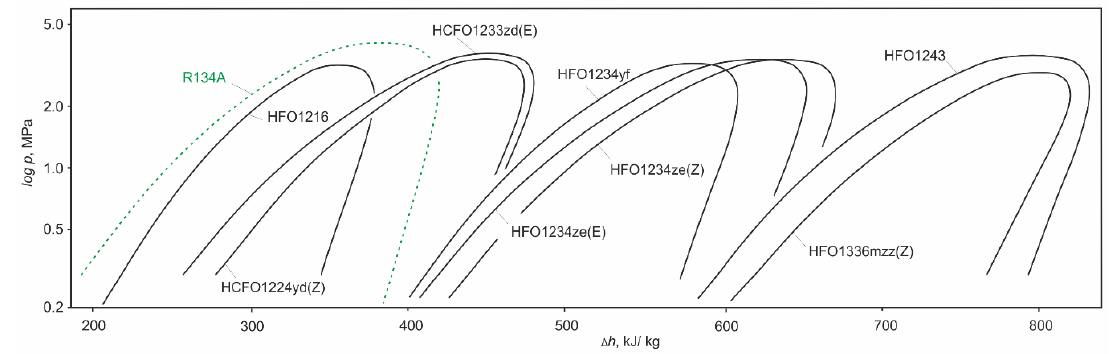
Figure 2. Comparison of the saturation curves of HFO/HCFO refrigerants, collected in a p-h graph.